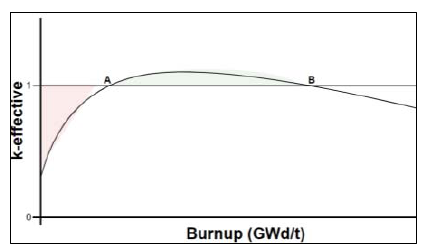
Figure 11. Representative reactivity- burnup